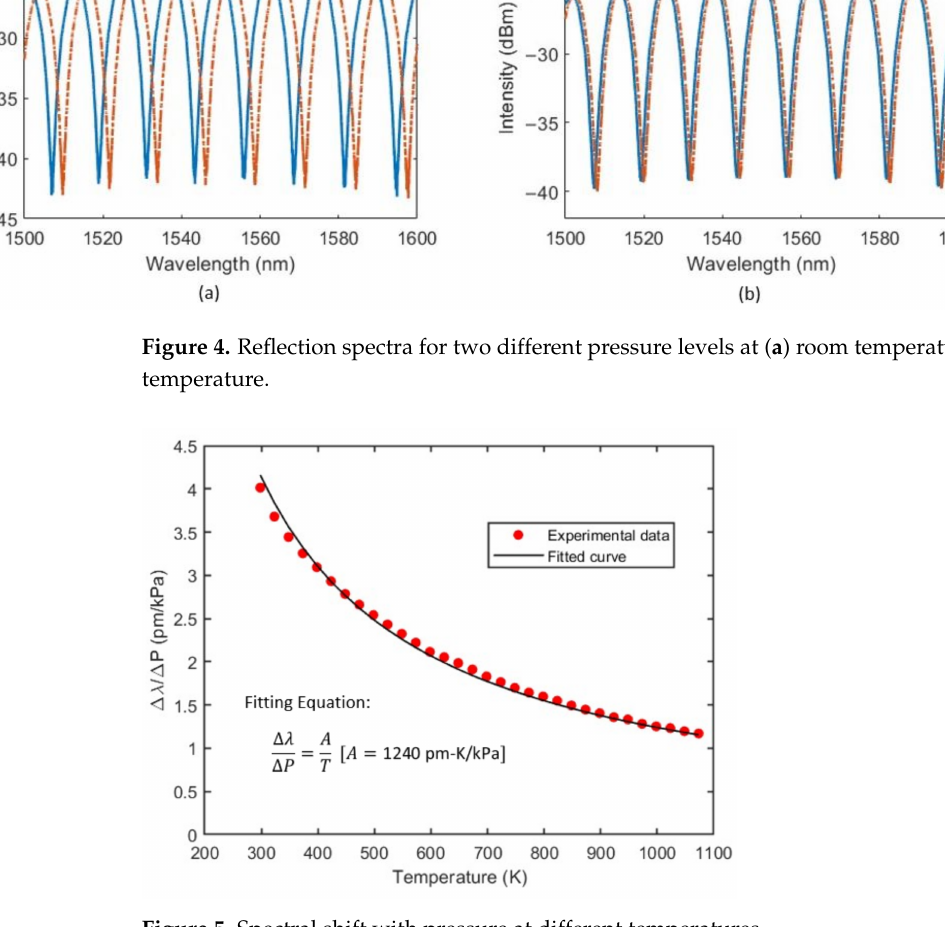
Figure 5. Spectral shift with pressure at different